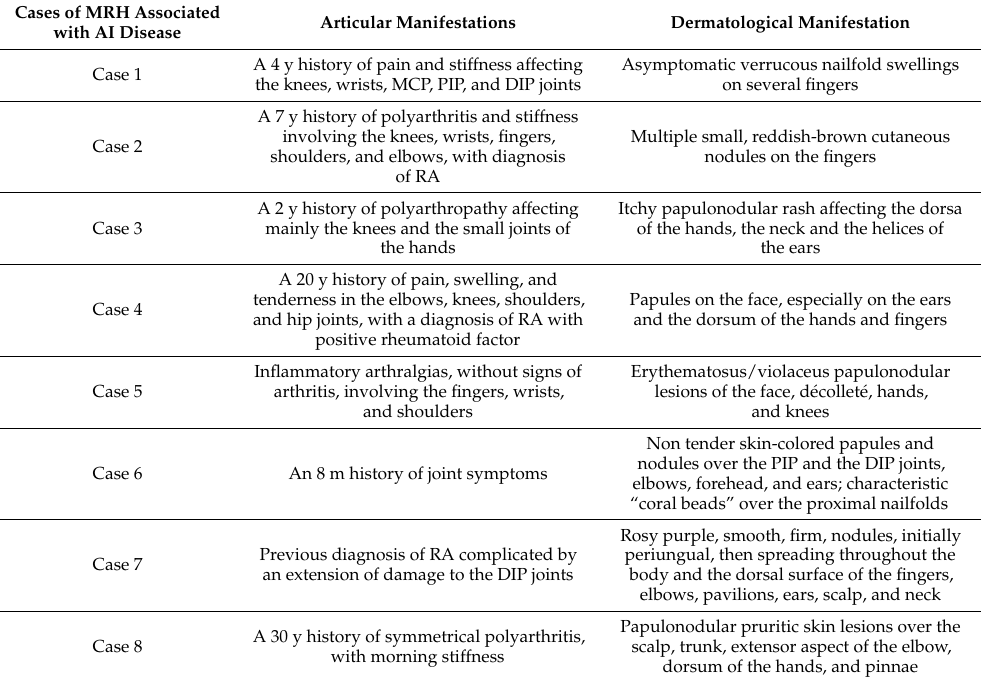
Table 2. Joints and cutaneous manifestations in 8 cases of MRH reported to be associated with autoim- mune diseases in the literature. y = years; AI = autoimmune diseases; MCP = metacarpophalangeal; PIP = proximal interphalangeal; DIP = distal